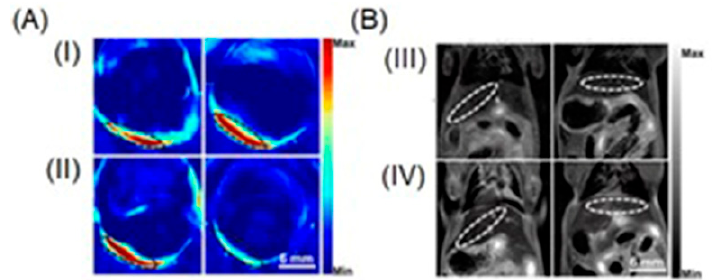
Figure 55. ( A ) Photoacoustic images of mice (I) before and (II) after intraperitoneally injected with Prussian blue and then treated with (left) saline and (right) paracetamol. ( B ) T 2 -weighted MRI images of mice (III) before and (IV) after intraperitoneally injected with Prussian blue and then treated with (left) saline and (right) paracetamol. Adapted with permission from Chen, F.; Teng, L.; Lu, C.;